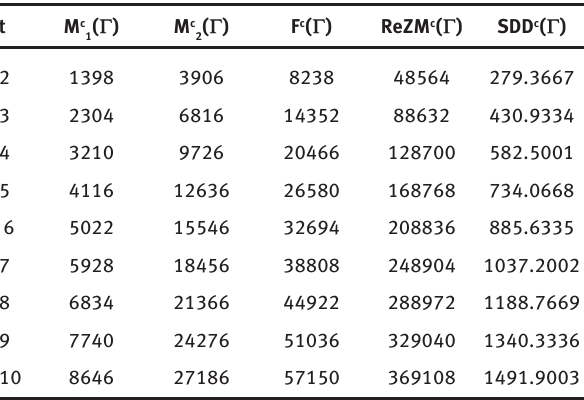
Table 12: Comparison among different Zagreb connection indices of MOF 2